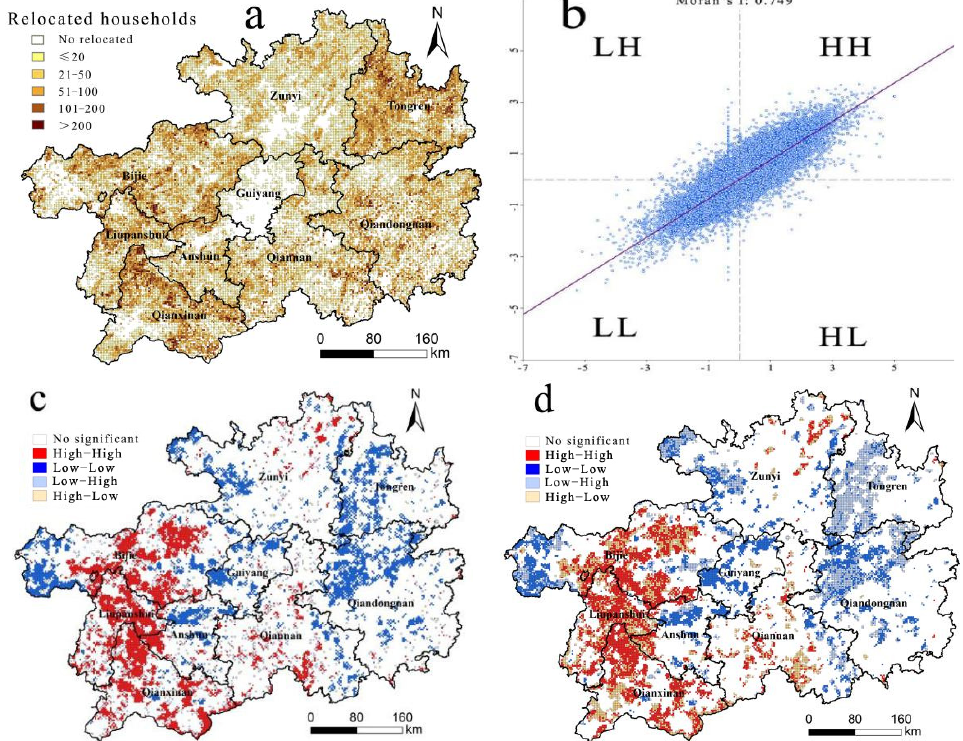
Figure 10. Coupling harmonious degree of density of relocated population and change of RSEI. ( a ) PAR density distribution; ( b ) Morlan index of 0.749, with an overall substantial spatial correlation; ( c ) Univariate local Morlan index, RSEI variables were extremely clustered; ( d ) Bivariate Morlan index, H–H in the west, relocation population with more RSEI increased remarkably, H–L concentrated around H - H, relocation population with less RSEI also increased noticeably, L–H concentrated in the east, relocation population with more RSEI exhibited a decreasing trend, L–L concentrated in areas with comparatively good economy, and relocation population and the RSEI decreased with less relocation population.